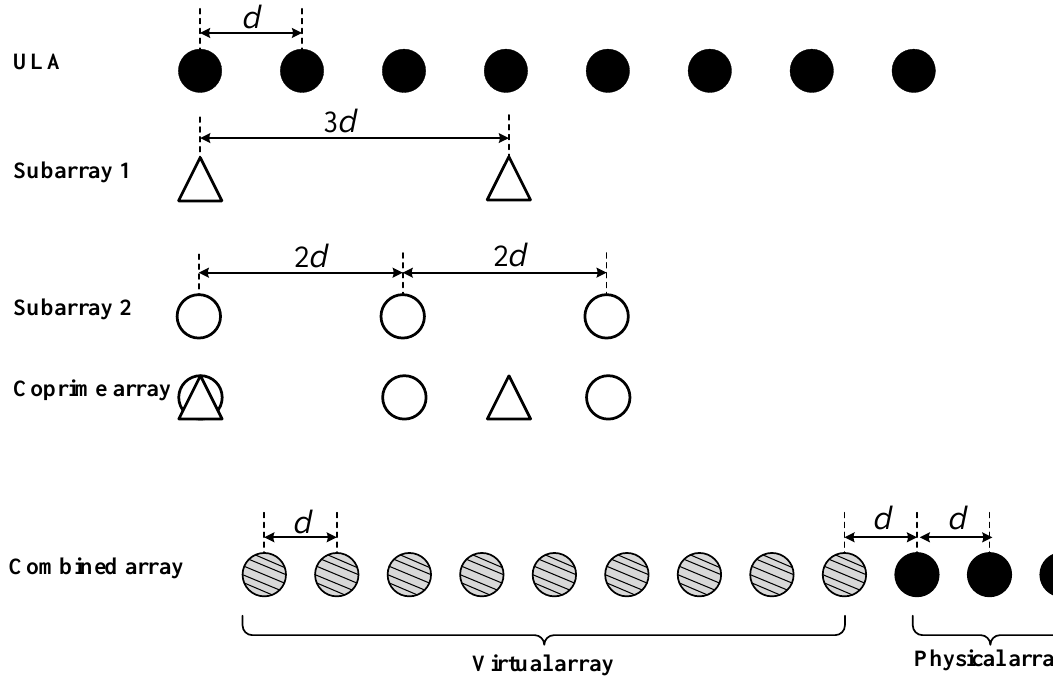
Figure 12. Equivalent antenna schematic.